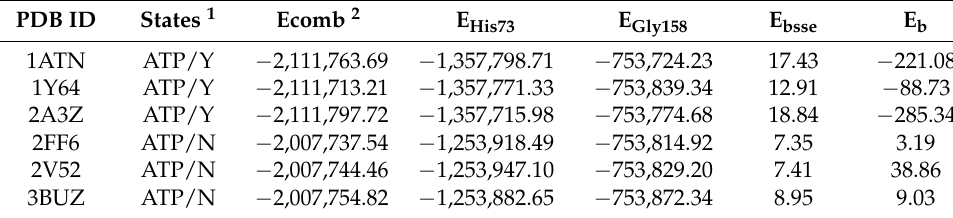
Table 1. His73/Gly158 binding energy calculation results in different methylation states.